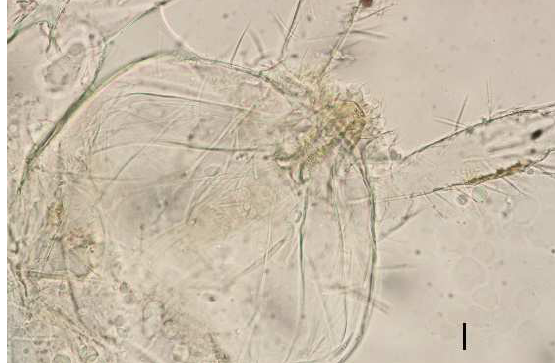
F IGURE 13. C. albinus without eye (scale: 100 µm)